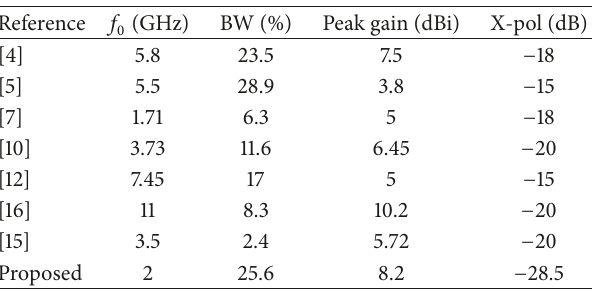
Table 1: Comparison of the dielectric resonator